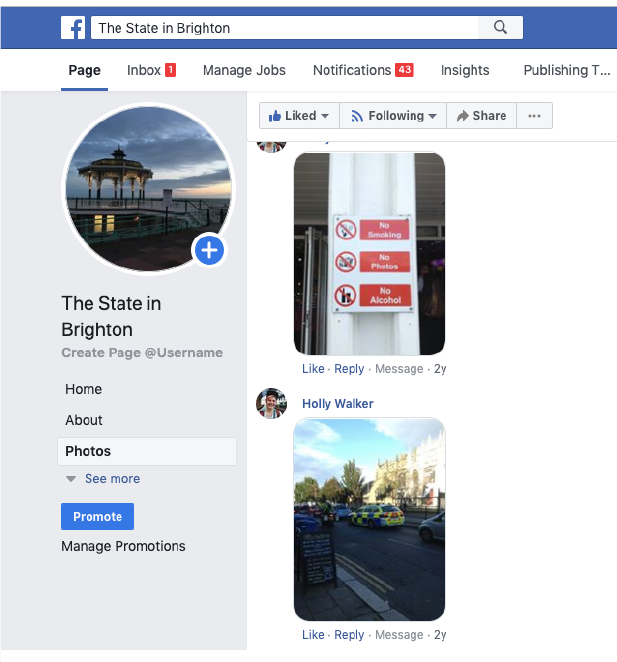
FIGURE 5. LOOKING FOR THE STATE IN